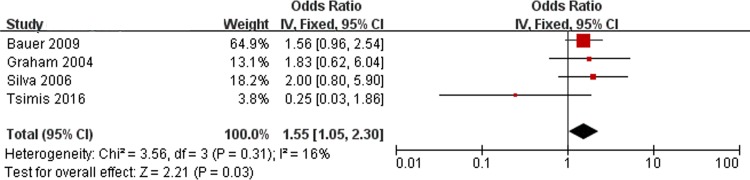
Fixed-effect model forest plot of the odds ratio of the association between oligohydramnios and PVL.The pooled OR of oligohydramnios is presented as a solid diamond at the bottom of the forest plot, the width of which represents the 95% CI.